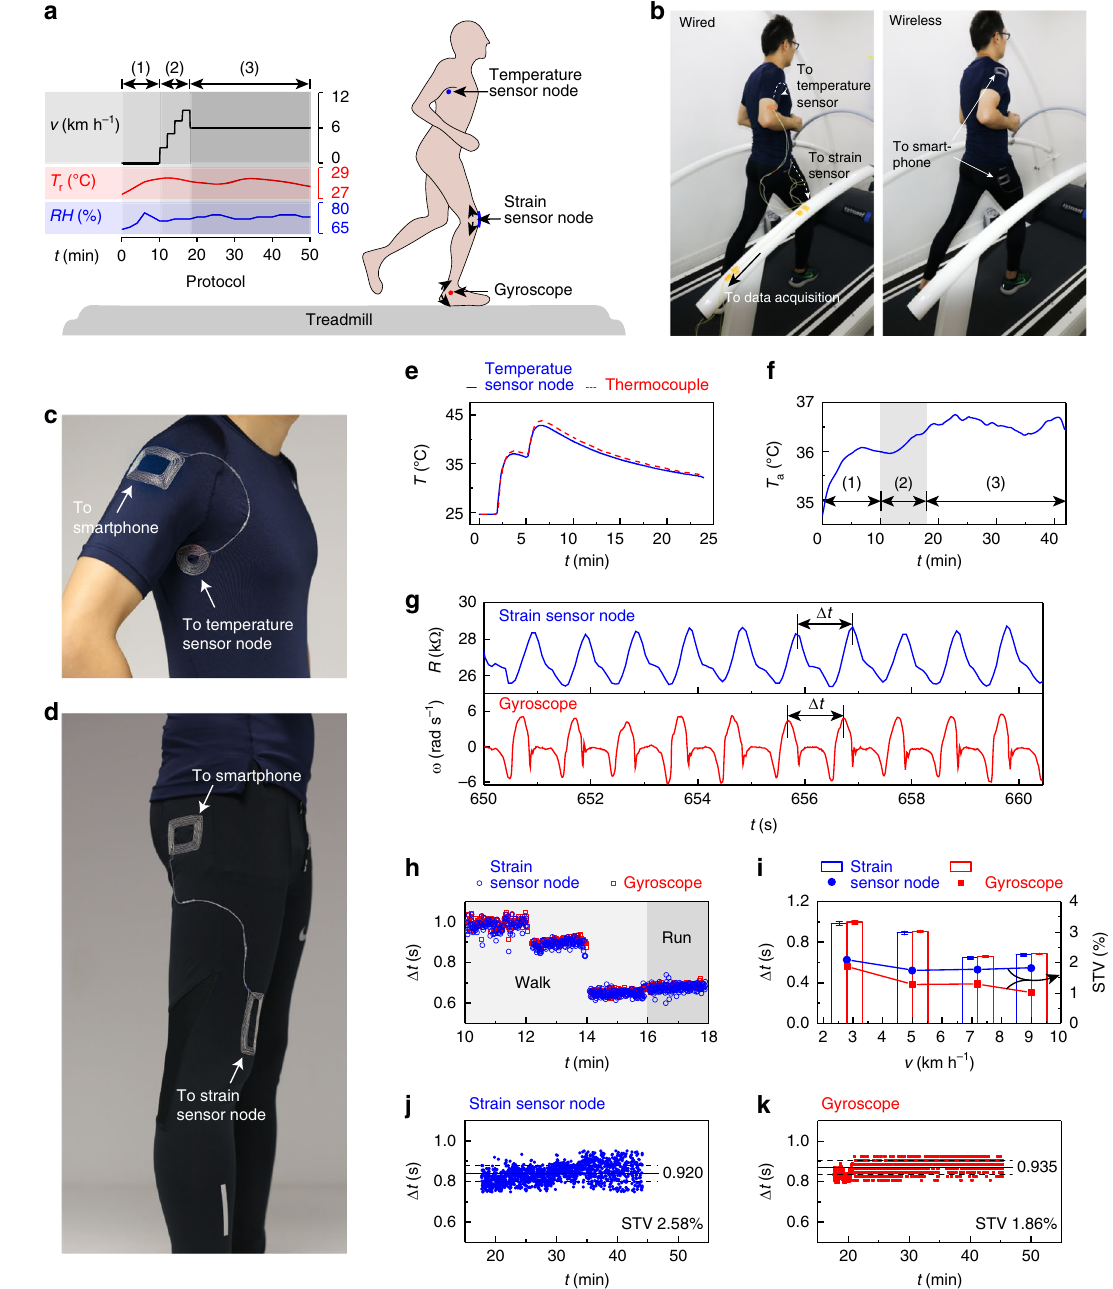
Fig. 4 Continuous exercise monitoring with battery-free sensors. a Experimental protocol and sensor placement. The subject performs (1) sitting, (2) walking/running at 2.8, 5, 7.2, and 9 km h − 1 , and (3) walking at 6 km h − 1 in a thermal chamber (28 °C, 70% relative humidity). Battery-free sensors provide temperature and strain measurements when interconnected to a smartphone. A gyroscope attached at the ankle is used as reference for gait monitoring. b Comparison of a wired and wireless monitoring system. c , d Images of near- fi eld-enabled shirt ( c ) and pants ( d ) for sensor interconnection. e Battery-free temperature sensor node calibration compared to wired thermocouple. f Axillary temperature T a recorded by the smartphone during the exercise protocol. g Representative strain sensor and gyroscope measurements during walking at 2.8 kmh − 1 . Δ t , stride time given by the peak-to-peak interval. h Δ t measured by the strain sensor node and gyroscope during phase (2). i Comparison of Δ t and stride time variability (STV) acquired by the strain sensor node and gyroscope. Error bars show mean ± s.d. ( n = 120 measurements). j , k Δ t and STV measured by the strain sensor node ( j ) and gyroscope ( k ) during phase